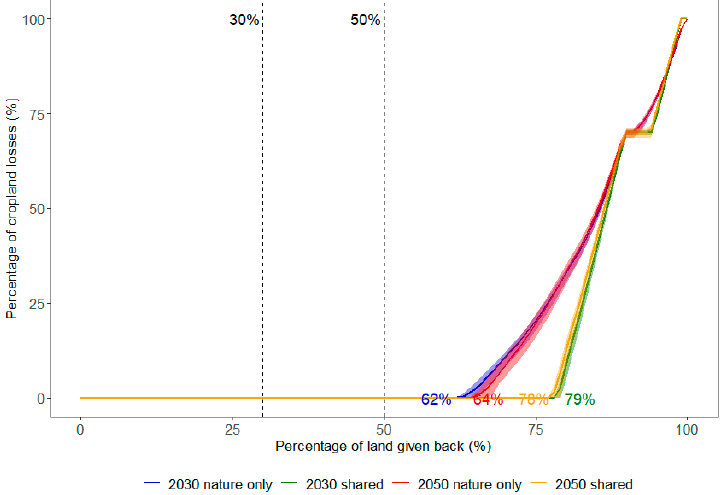
Figure 6. Predicted cropland losses at a global scale. The curve reflects the mean value of all 8 scenarios and the shadows show ranges of all scenarios. Percentage of cropland losses is the area percentage of global conserved cropland to global cropland. The specific percentage of land given back at which cropland begins to be abandoned is marked. Land given back and cropland losses are both shown in percentages.